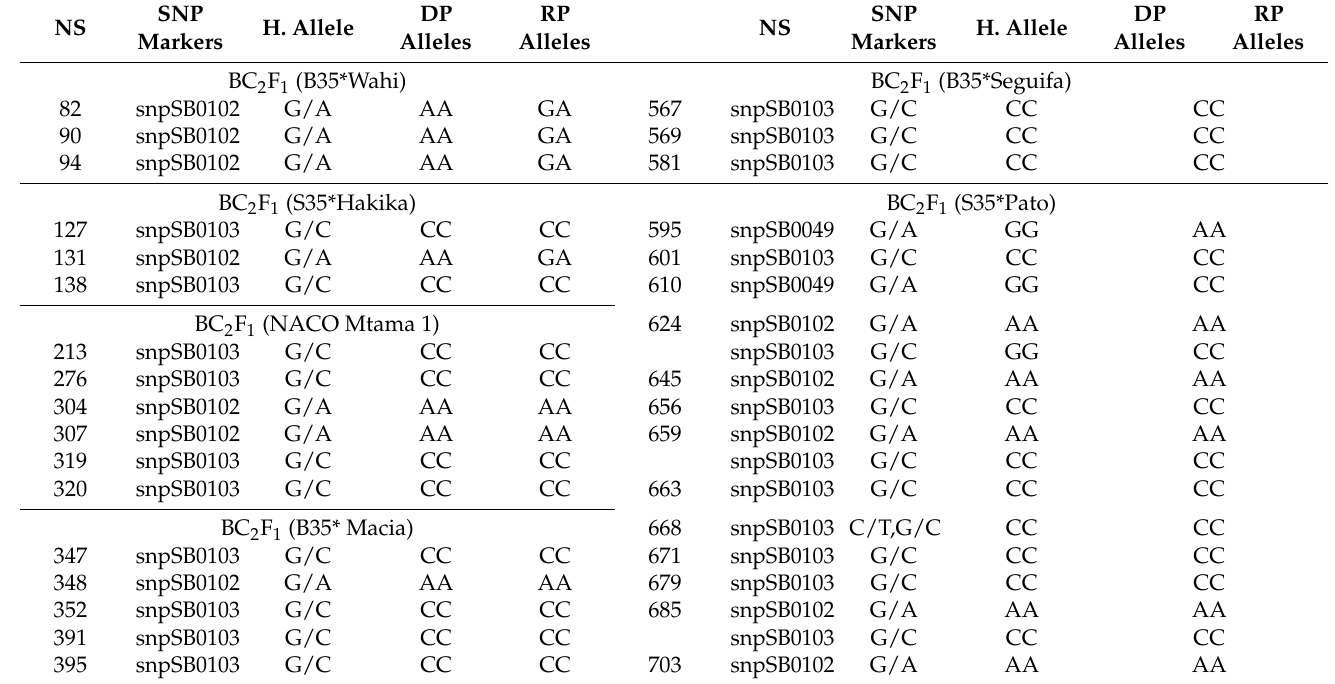
Table 3. BC 2 F 1 sorghum populations scored with heterozygous alleles using SNP markers.